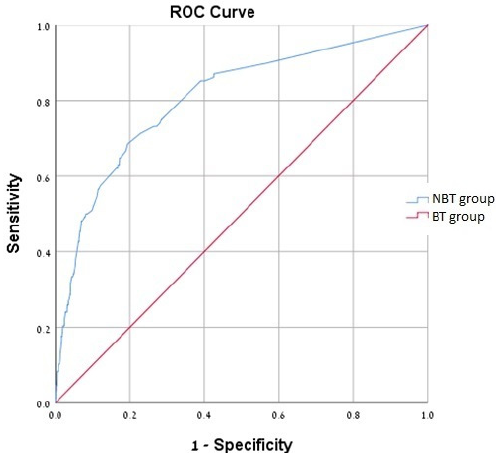
Figure 3. Receiver operating characteristic curve, AUC = 0.806–95% CI [0.760–0.852]. Table 5. Multivariable regression model for blood transfusion during hospitalization.